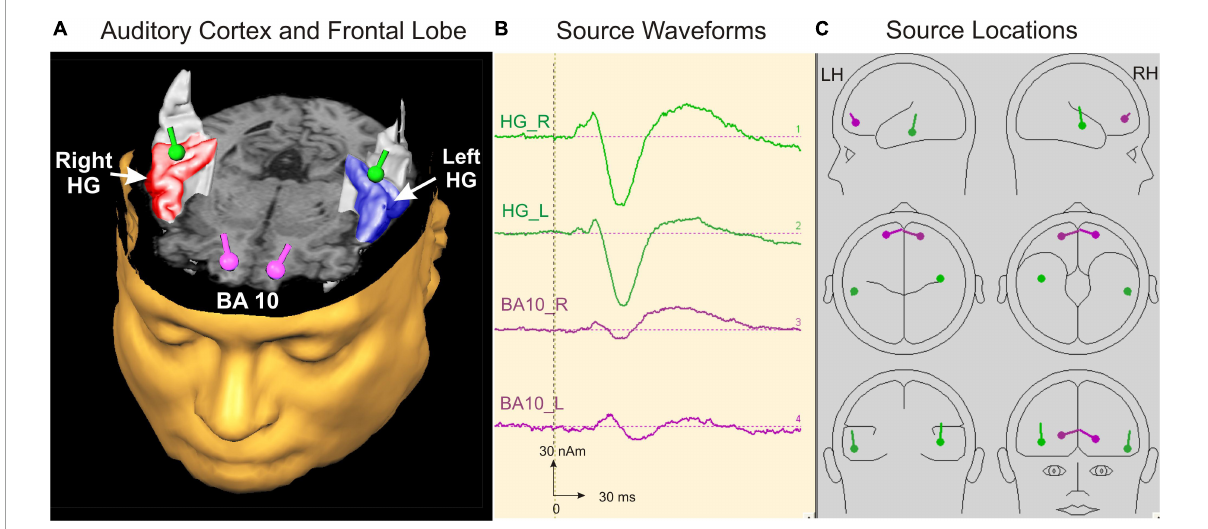
FIGURE2 Source modeling in auditory cortex and frontal lobe. (A) Top view on the left and right auditory cortex including the right (red) and left (blue) Heschl’s gyrus and the localization of the primary auditory evoked and orbitofrontally seeded responses depicted as green and pink dipoles bilaterally, respectively. (B) Source waveforms of the left and right primary activity (green) and the orbitofrontally seeded musical aesthetic activation (pink). (C) Source locations of the four dipoles projected in a spherical head model calculated with BESA software (Scherg,